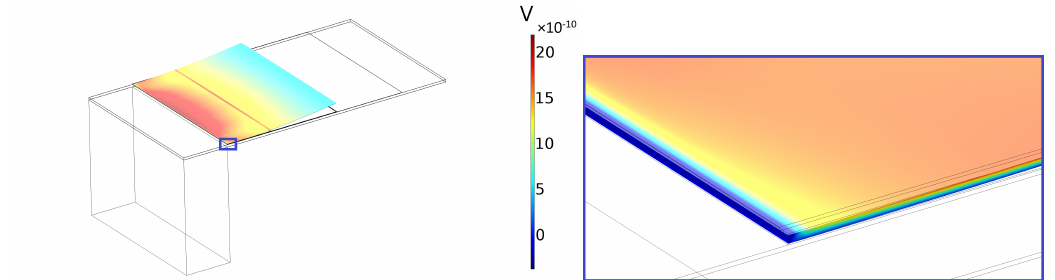
Figure 7. The piezoelectric material electric potential distribution due to the cantilever beam first mode resonance frequency.